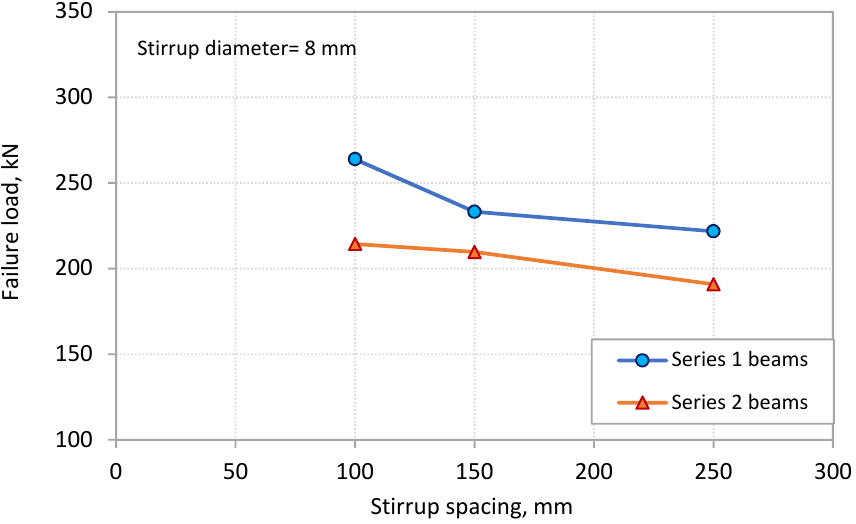
Figure 8. Effect of stirrup spacing on PE debonding capacity.